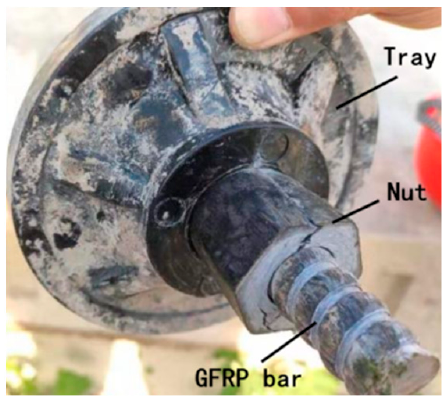
Figure 2. Connection of tray, nut and GFRP bar.